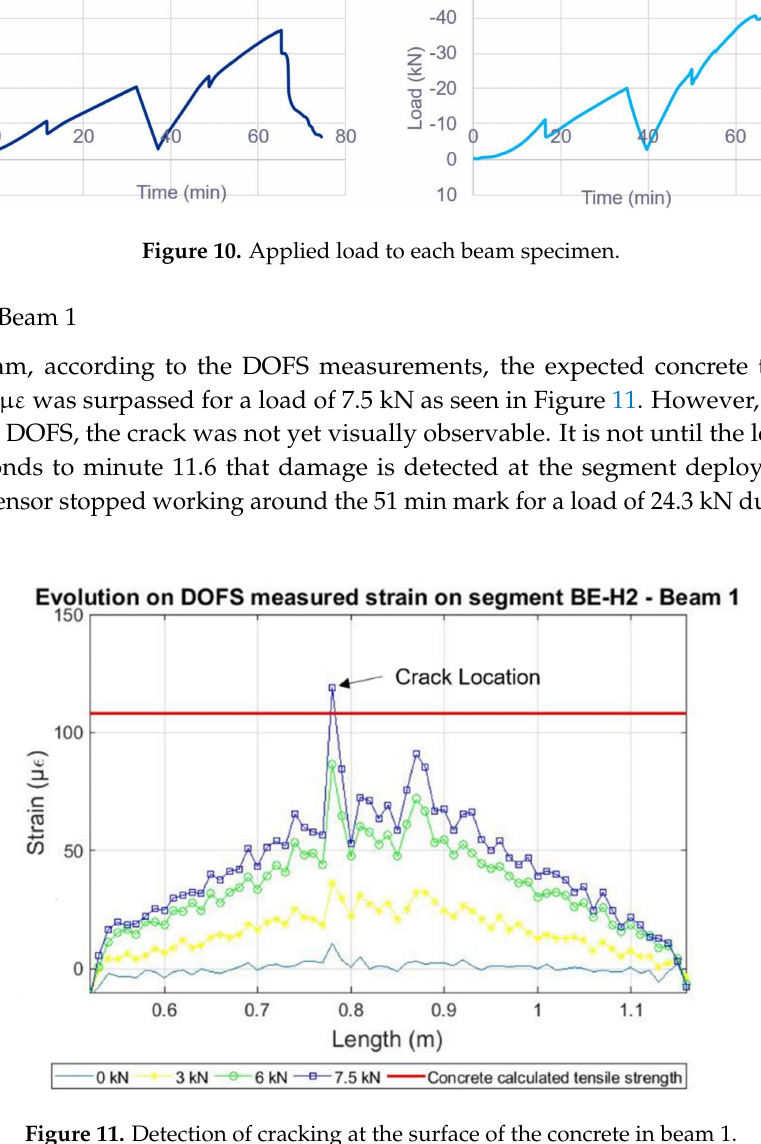
Figure 11. Detection of cracking at the surface of the concrete in beam